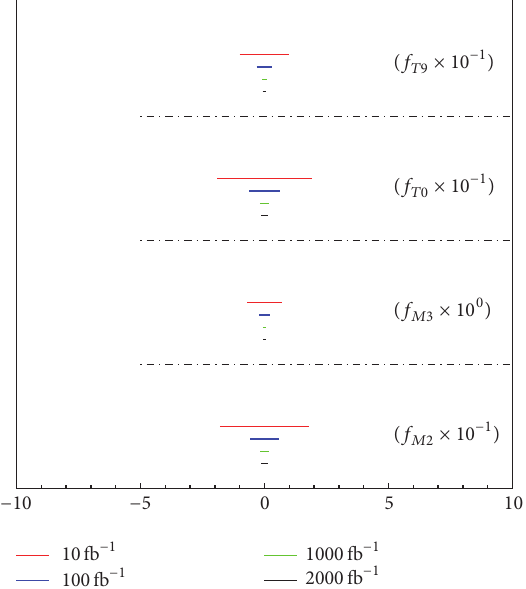
Figure 6: 95% CL sensitivity bounds of 𝑓 𝑀2 /Λ 4 , 𝑓 𝑀3 /Λ 4 , 𝑓 𝑇0 /Λ 4 , and 𝑓 𝑇9 /Λ 4 couplings for various values of integrated luminosities and √𝑠 = 3 TeV through the process 𝑒 − 𝛾 → 𝑒 − 𝛾 ∗ 𝛾 → 𝑒 − 𝑍 𝑍